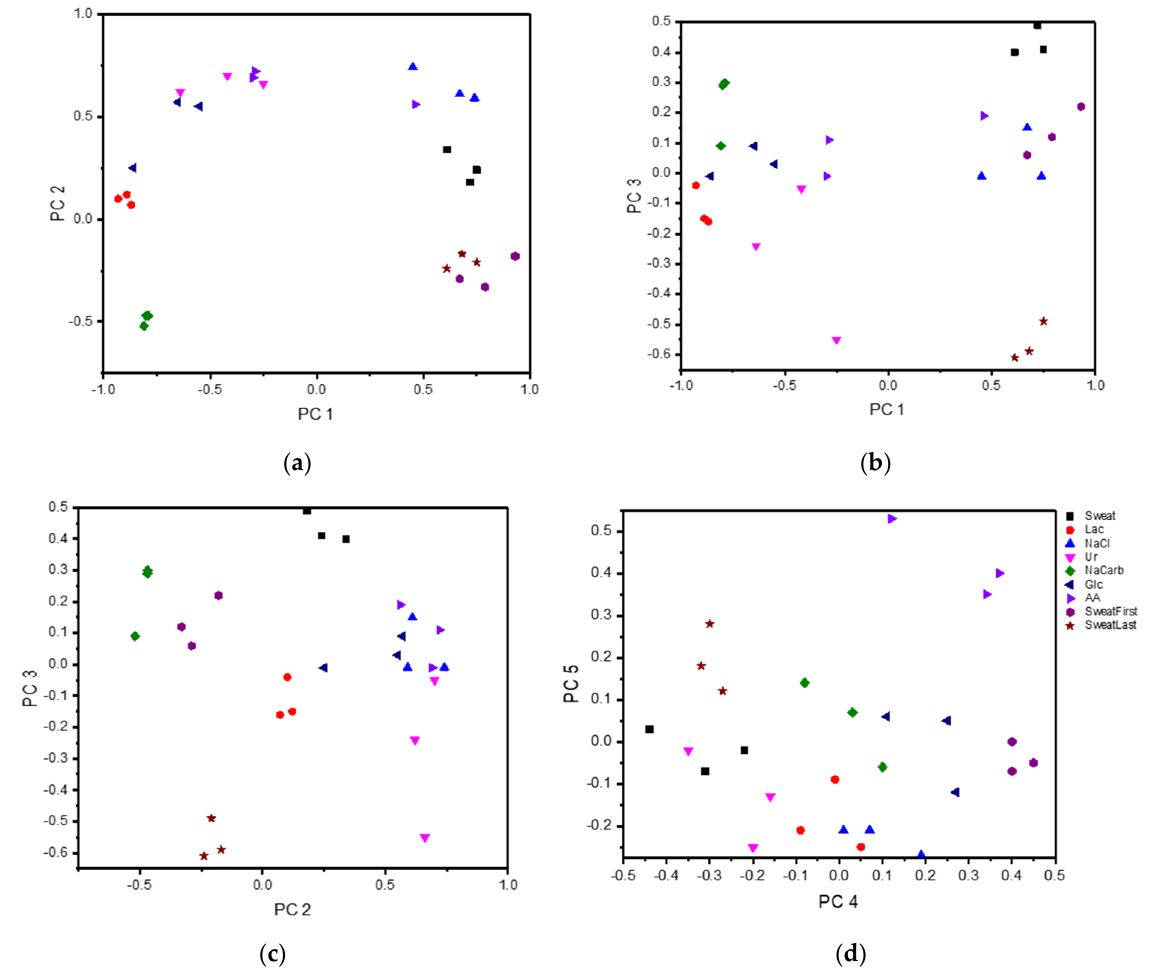
Figure 6. PCA score plots of three different repeat measurements using a wearable e-tongue (Device 3) in vitro in sweat